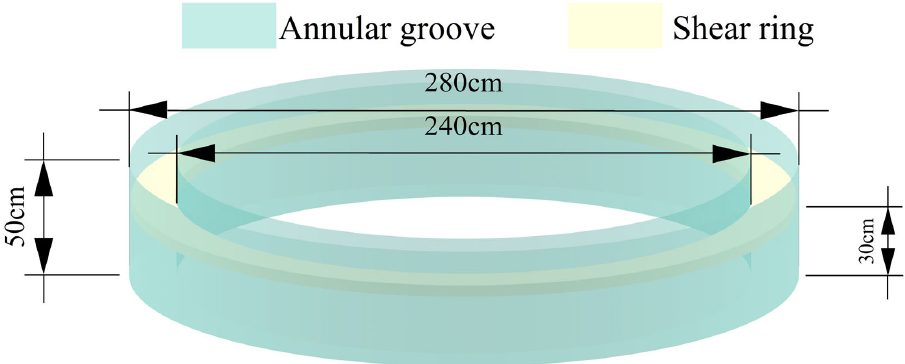
Figure 1. Dimensions of the ring sink model.